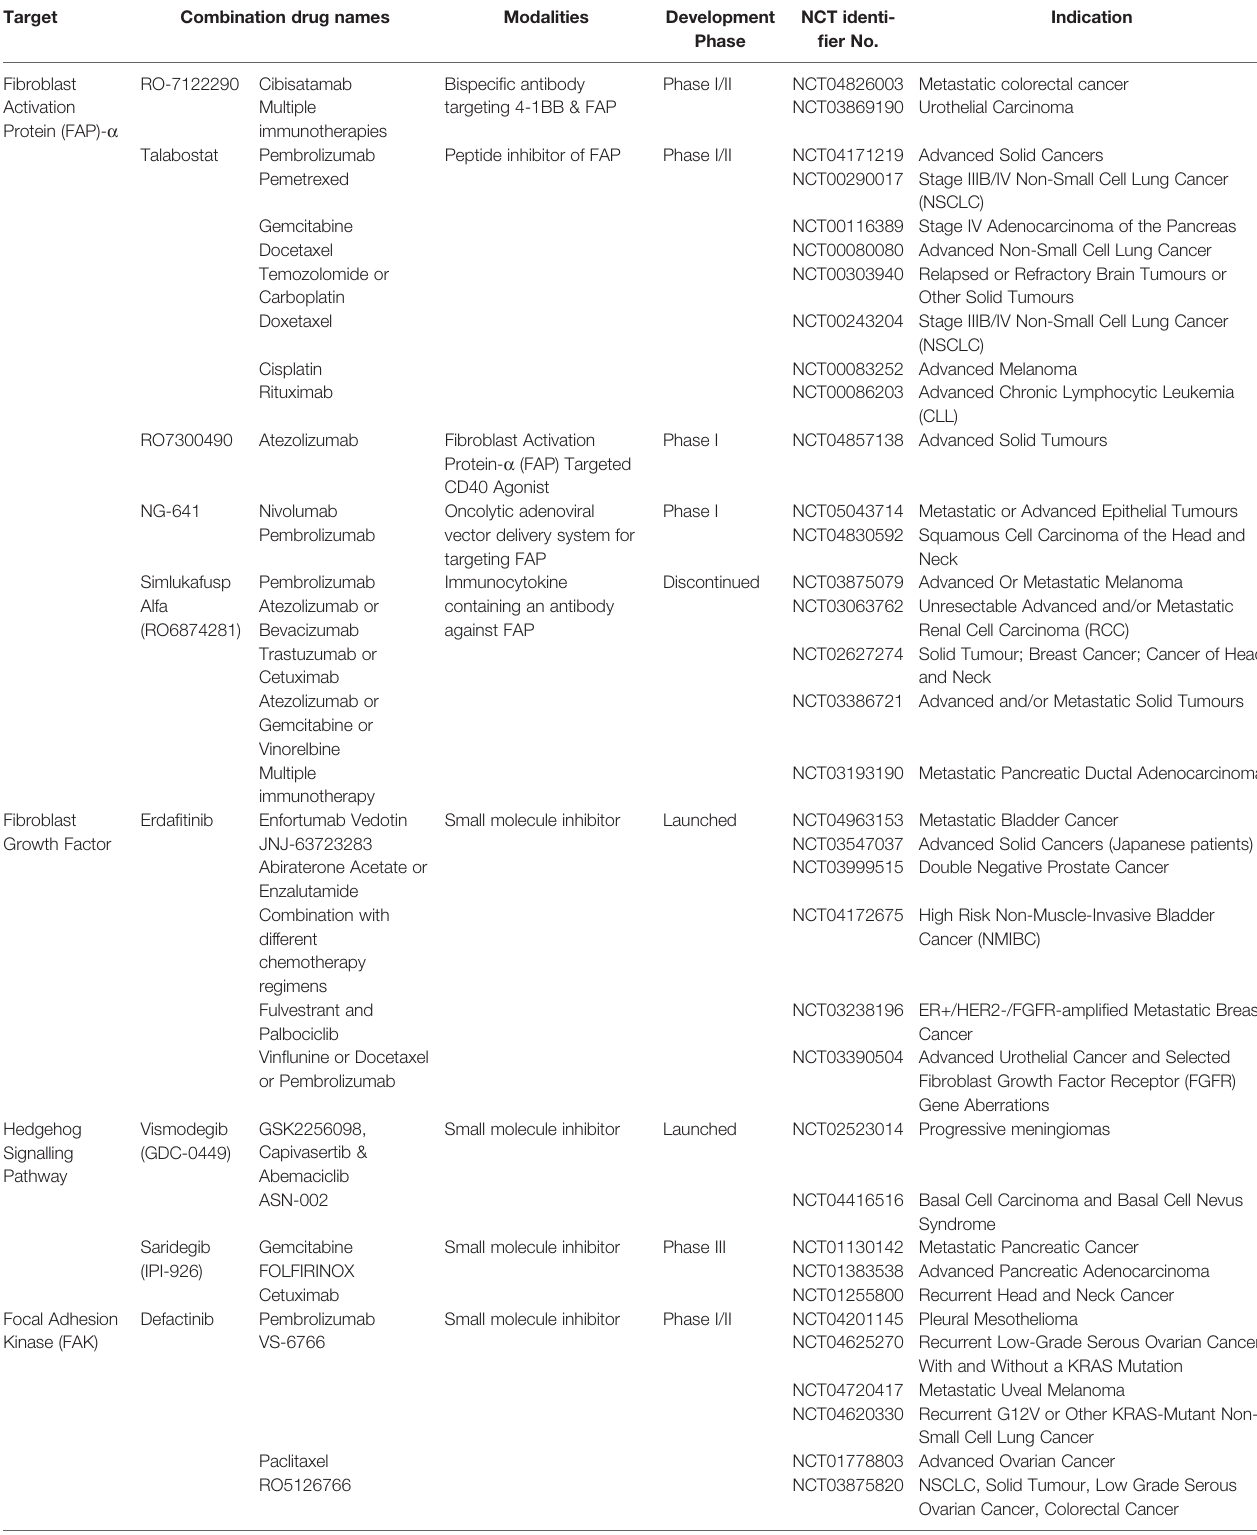
TABLE 2 | A representative panel of current clinical trials with either solid tumour microenvironment modifying or tumour-associated fi broblasts targeting agents in combination with FDA-approved immune-oncology therapies.